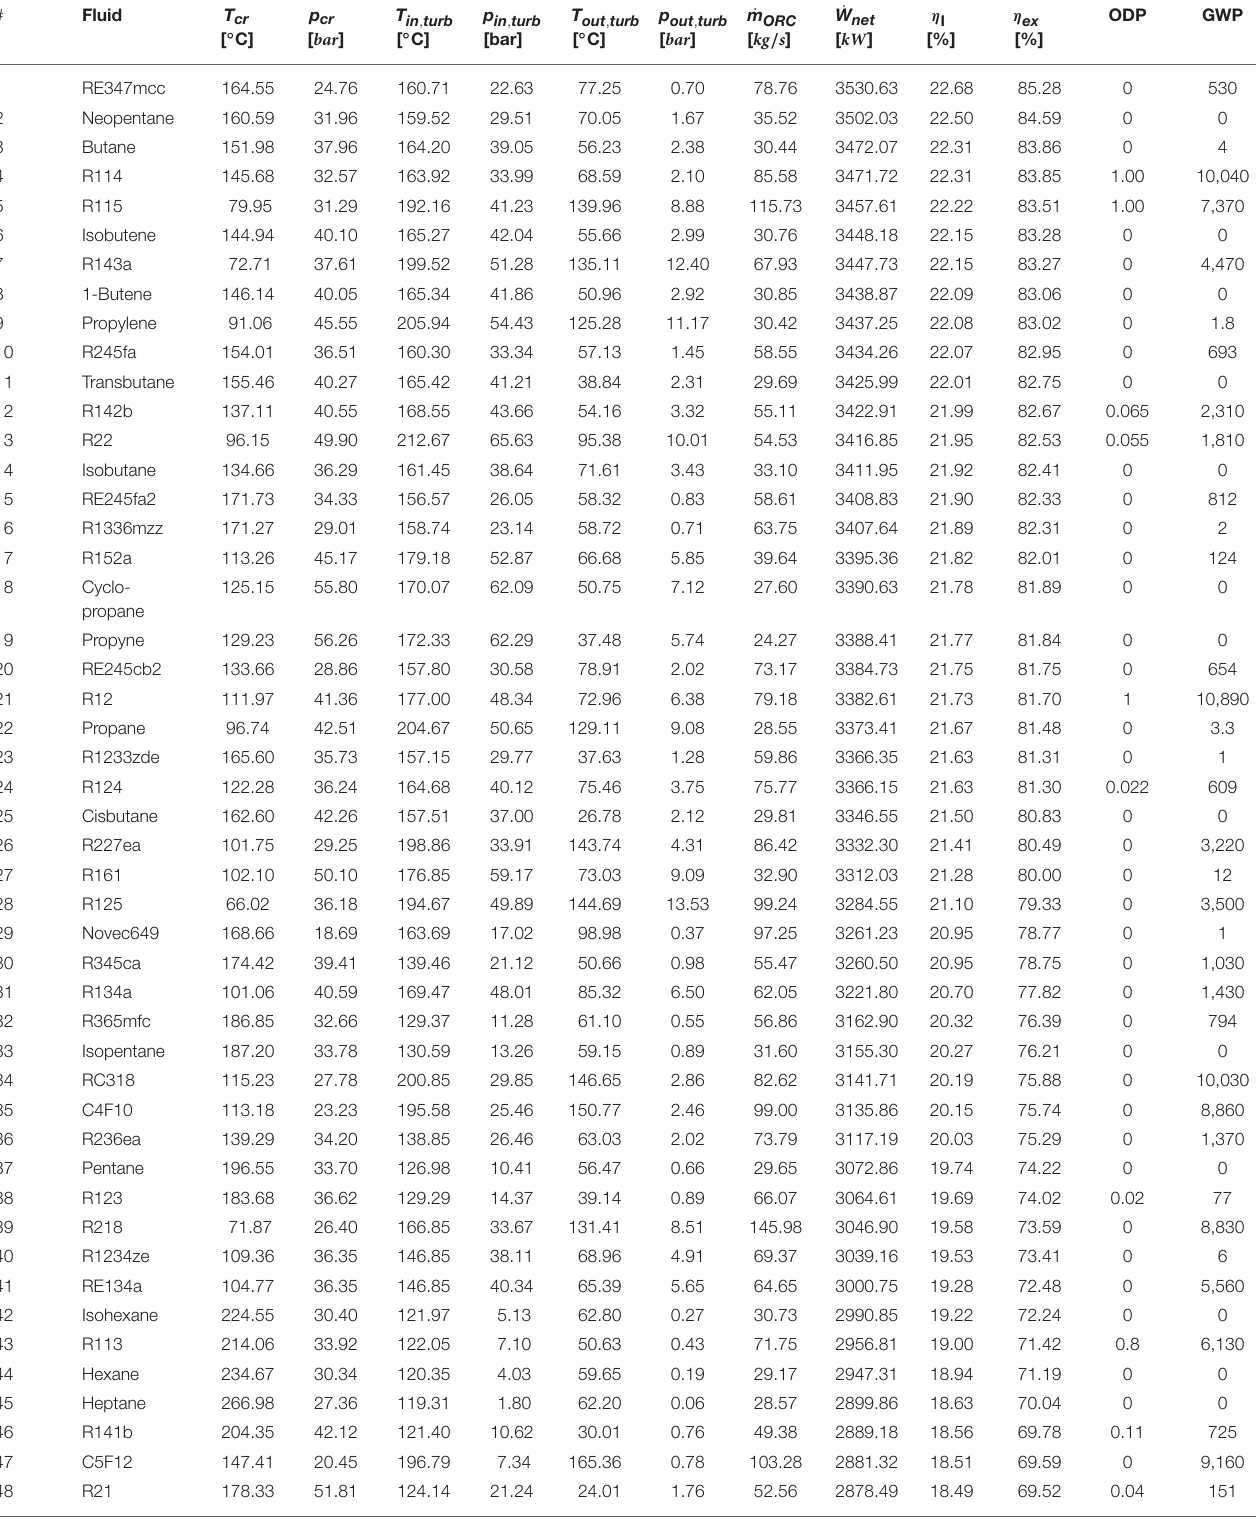
TABLE A1 | Thermodynamic optimization results of all pure fluids ranked according to the exergy